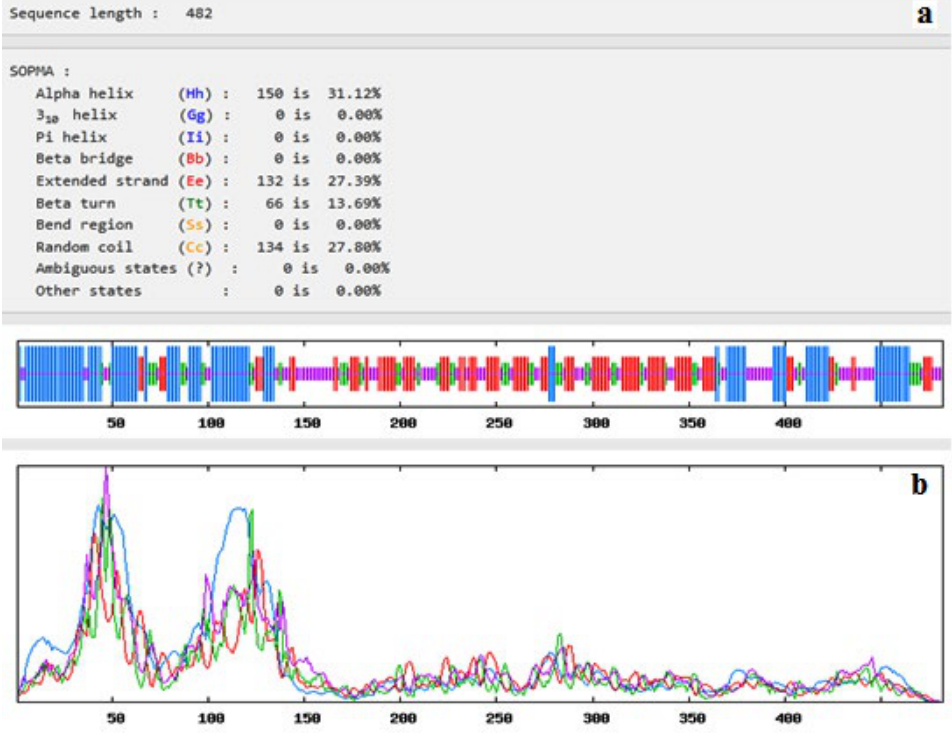
Fig. 4. Secondary structure prediction plot of the vaccine construct. Alpha helices were shown in blue colour, while extended strands and beta turns were shown by red and green colours, respectively. (a) The visualization of the prediction and (b) the score curves for each predicted Table 3. The predicted T helper cells epitopes, their antigenicity, allergenicity, toxicity from AEV polyprotein Epitope